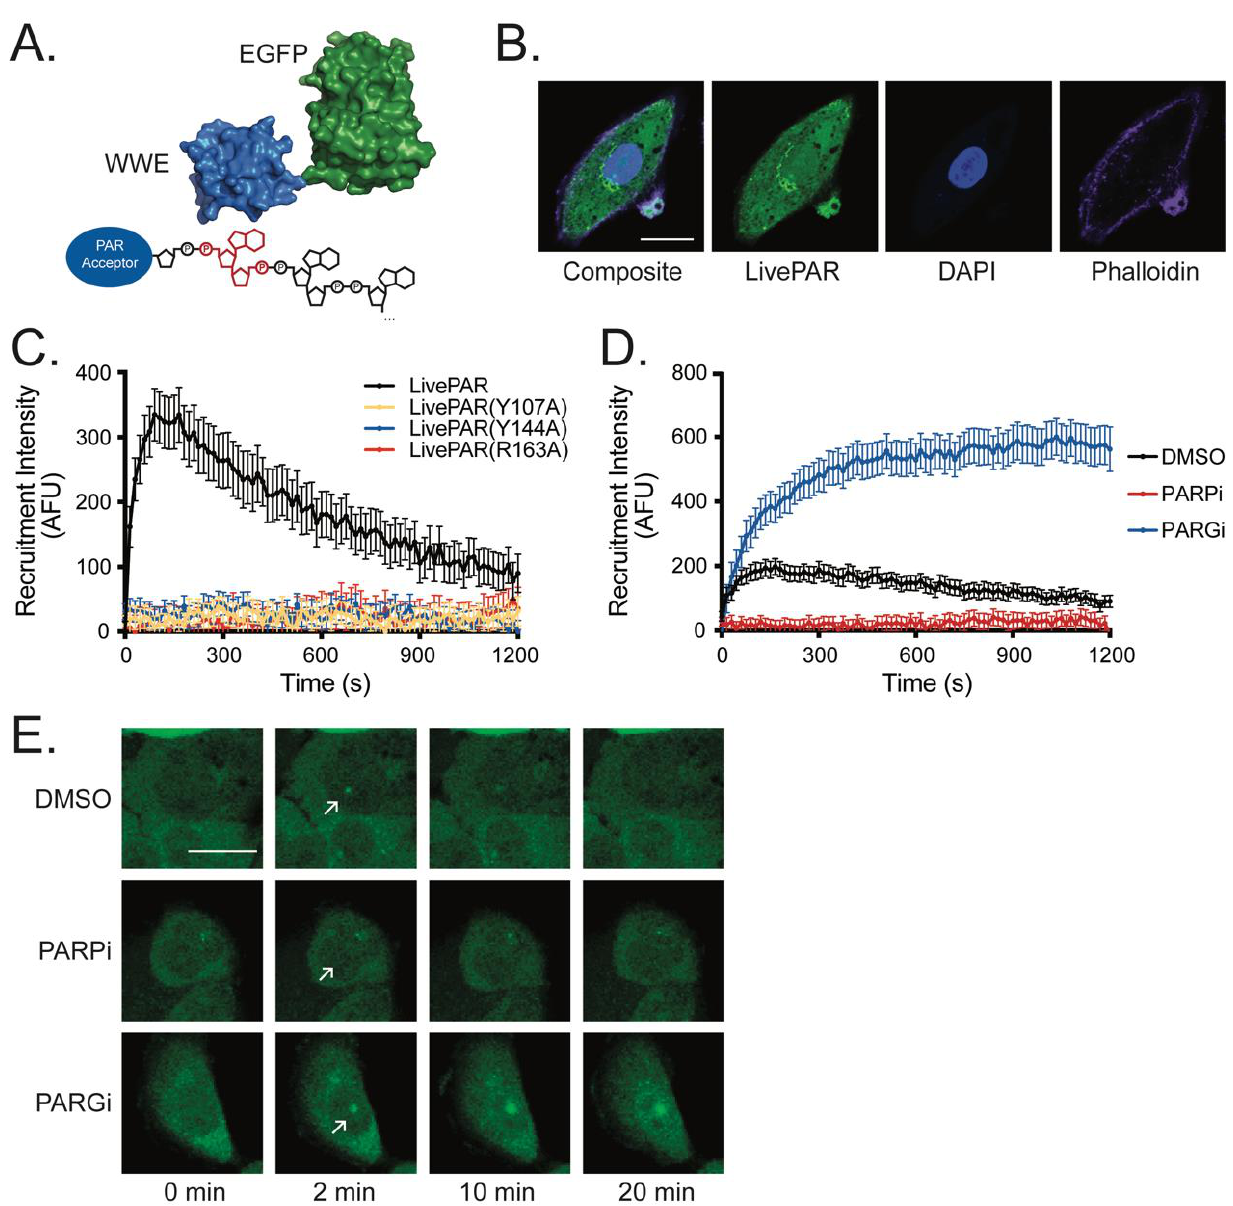
Figure 1. LivePAR as a molecular probe to investigate PARylation in live cells. ( A ) LivePAR is a fusion of the PAR-binding WWE domain from RNF146 (blue; PDB 3V3L) and EGFP (green; PDB 2Y0G) that preferentially binds to the iso-ADP-ribose moiety (red) of PAR chains [36,40]. ( B ) Expression of LivePAR in A549 cells. White scale bar denotes 20 µ m. ( C ) Recruitment of LivePAR to sites of laser micro-irradiation (405 nm laser). Mutations in amino acids that eliminate PAR binding in the WWE domain (Y107A, Y144A, or R163A) prevent LivePAR recruitment; N ≥ 40 cells. ( D ) LivePAR recruitment to sites of laser-induced DNA damage is attenuated following PARPi treatment, while PARGi enhances and prolongs LivePAR recruitment; N ≥ 40 cells. ( E ) Images of LivePAR-expressing A549 cells following laser micro-irradiation. PARPi prevents foci formation while PARGi strengthens and prolongs foci formation compared to control. White scale bar denotes 20 µm.